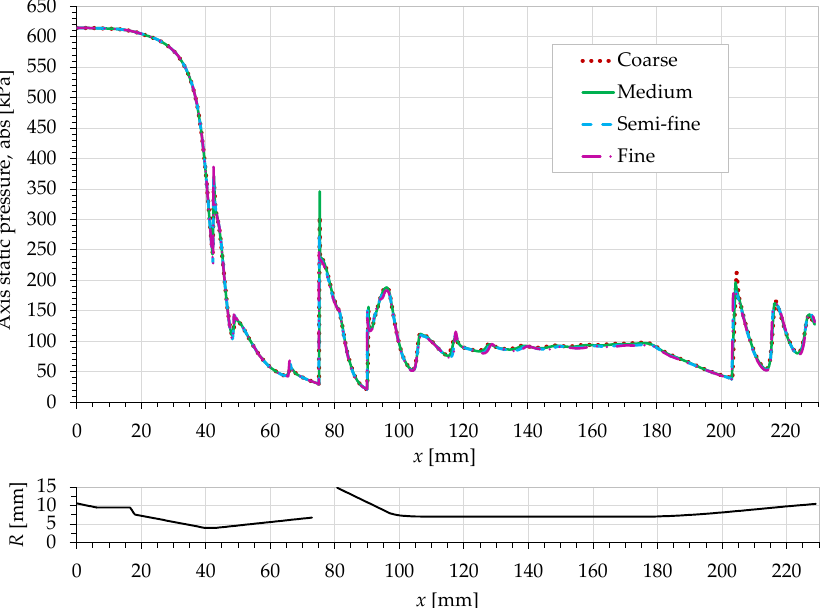
Figure 6. Absolute static pressure along the axis (top). The ejector internal contour (bottom) is also presented to see the corresponding location of the static pressure. The turbulence model is the transition SST model.